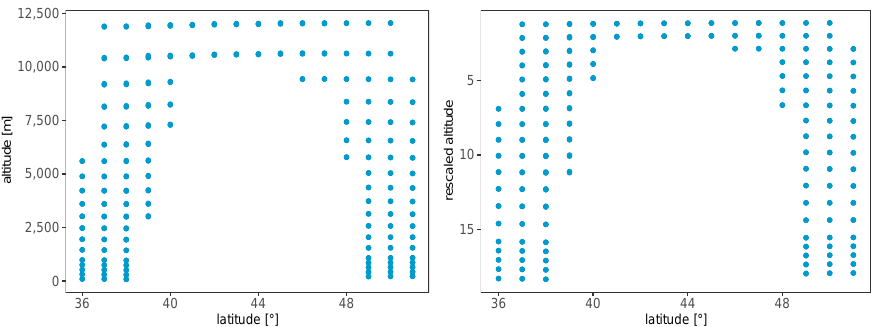
Figure 15. ( Left ) the original GFS data with various gaps along the altitude; ( Right ) rescaled altitude of the vertical dimension with (22).